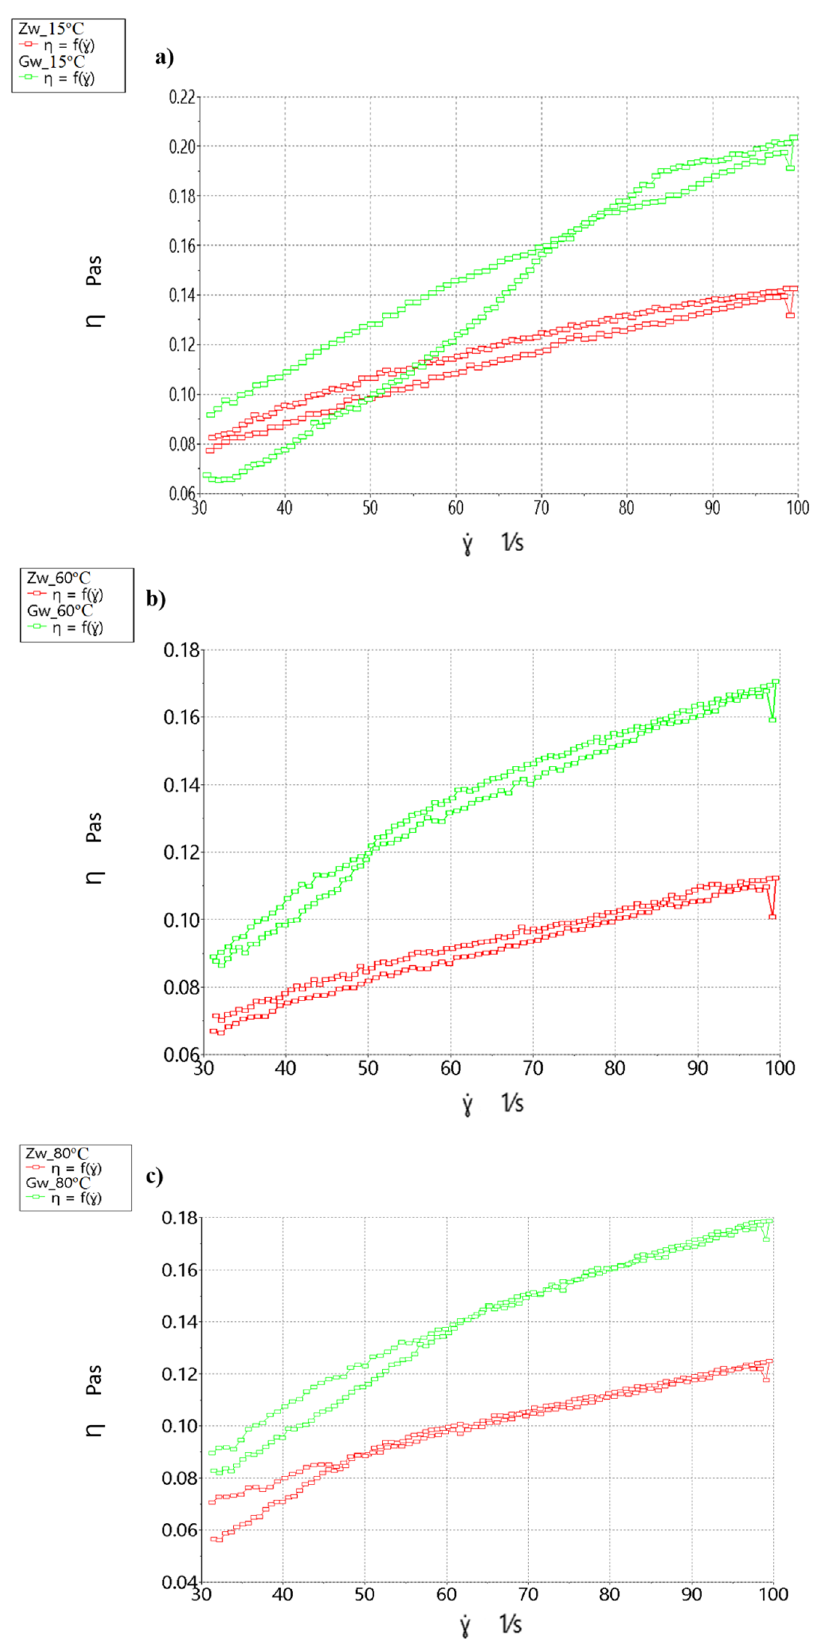
Figure 6. Viscosity and thixotropy loop of hops immersed in water, depending on the experimental variant, at ( a ) 15 ◦ C, ( b ) 60 ◦ C, and ( c ) 80 ◦